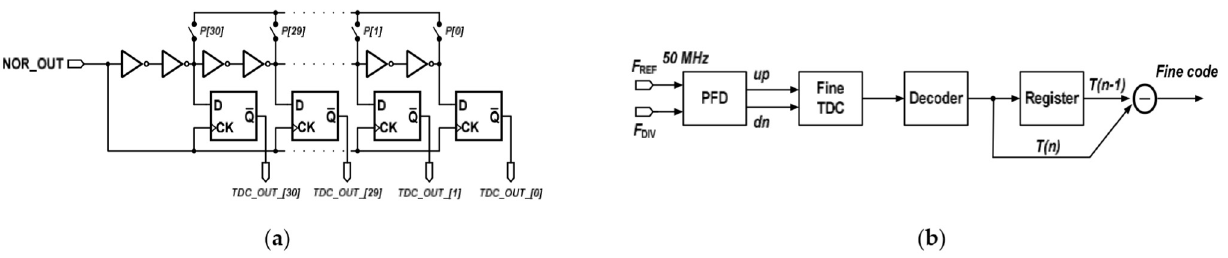
Figure 4. The proposed ( a ) coarse TDC structure using 31 stages; and ( b ) phase detector